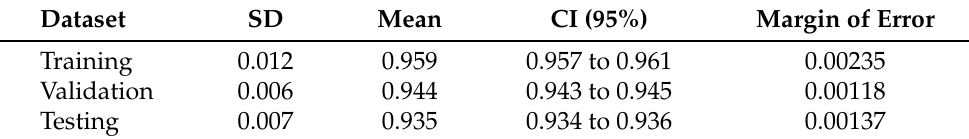
Table 4. Standard deviation and mean for training, validation, and testing accuracy.